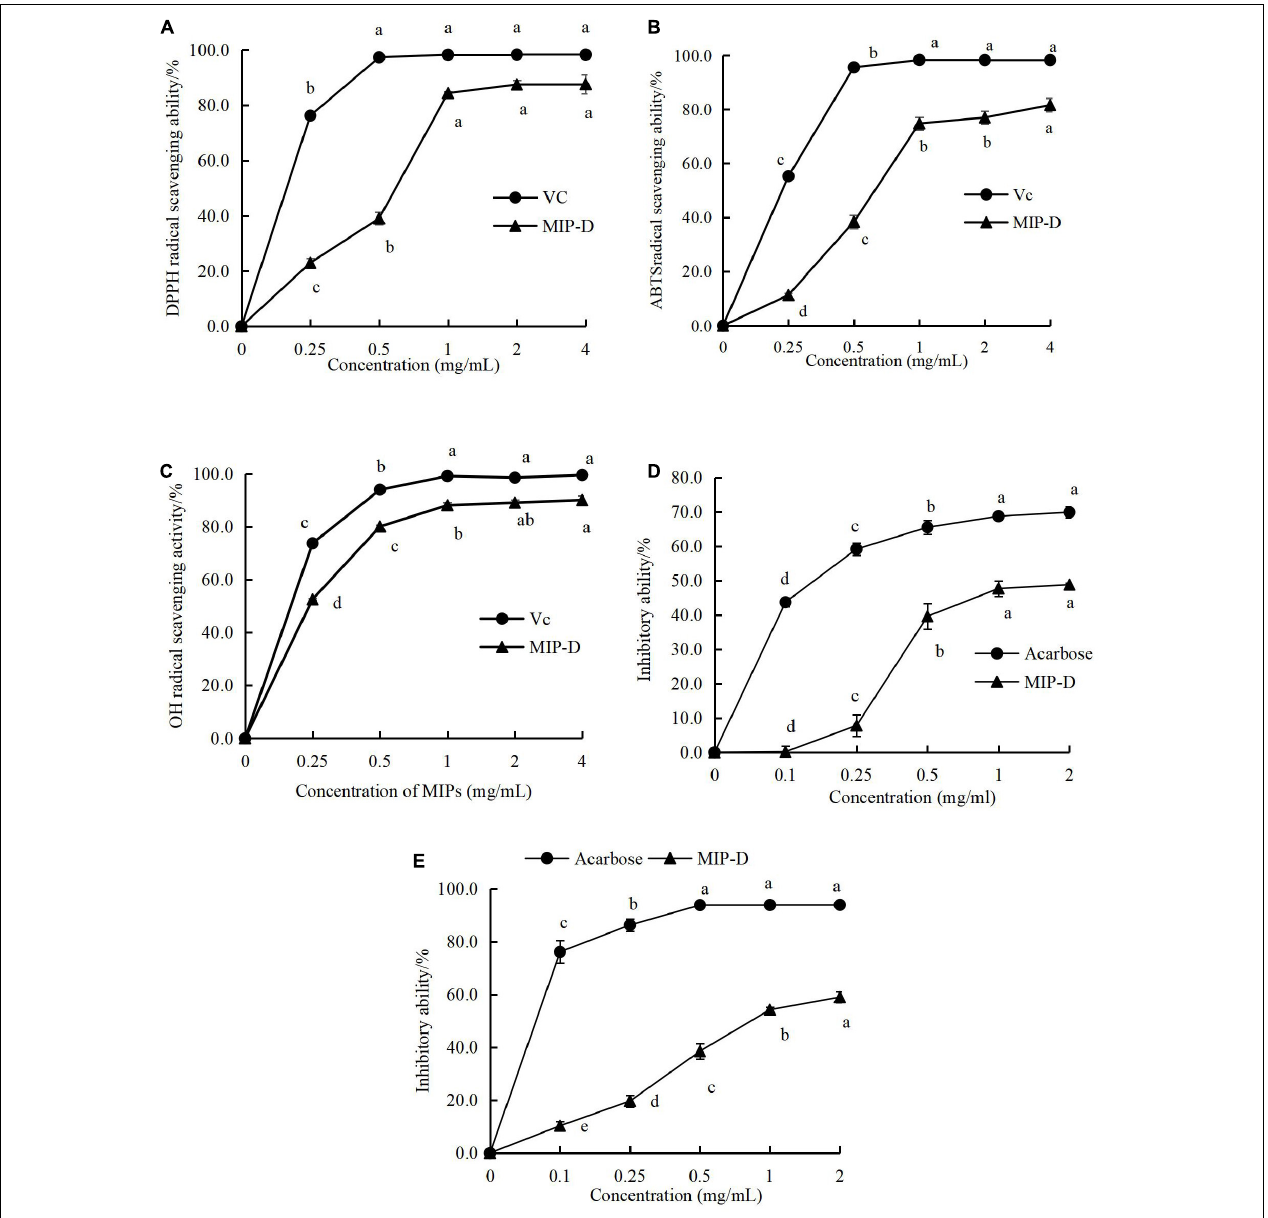
FIGURE 4 | Effect of MIP-D on antioxidant and hypoglycemic activity in vitro . (A) DPPH radical scavenging activity of MIP-D. (B) ABTS radical scavenging activity of MIP-D. (C) OH radical scavenging activity of MIP-D. (D) The inhibitory effects of MIP-D on α -glucosidase and (E) the inhibitory effects of MIP-D on α -amylase. Each value represents the mean ± SD ( n = 3). Significant ( p < 0.05) differences are shown by data bearing different letters (a–d).